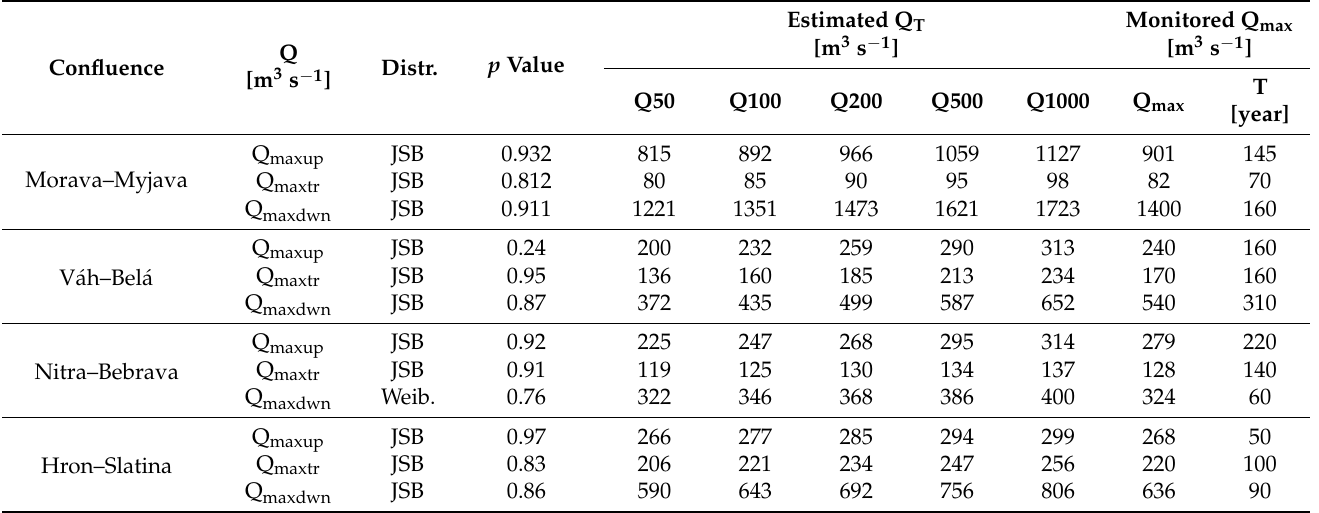
Figure 4. Comparison of the empirical exceedance probabilities (points) and the theoretical exceedance probability curves (line) of the maximum annual discharges for the selected mainstreams and tributaries during the analyzed periods. Table 3. Estimated univariate designed discharge Q max for various return periods T and p -values of the Kolmogorov–Smirnov test.